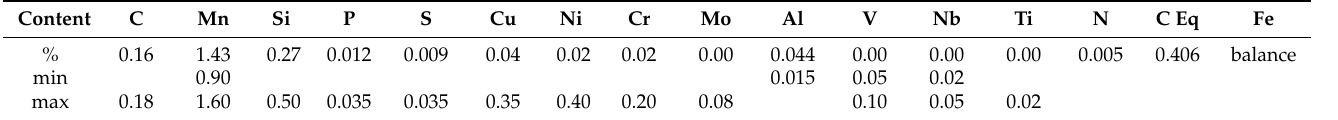
Table 2. Chemical composition of the AH36 steel (% weight).